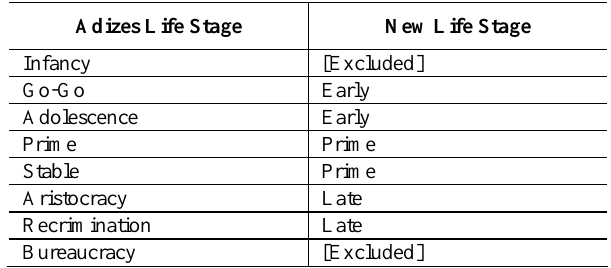
Table 3: Reclassification of the Adizes life stages into three broad